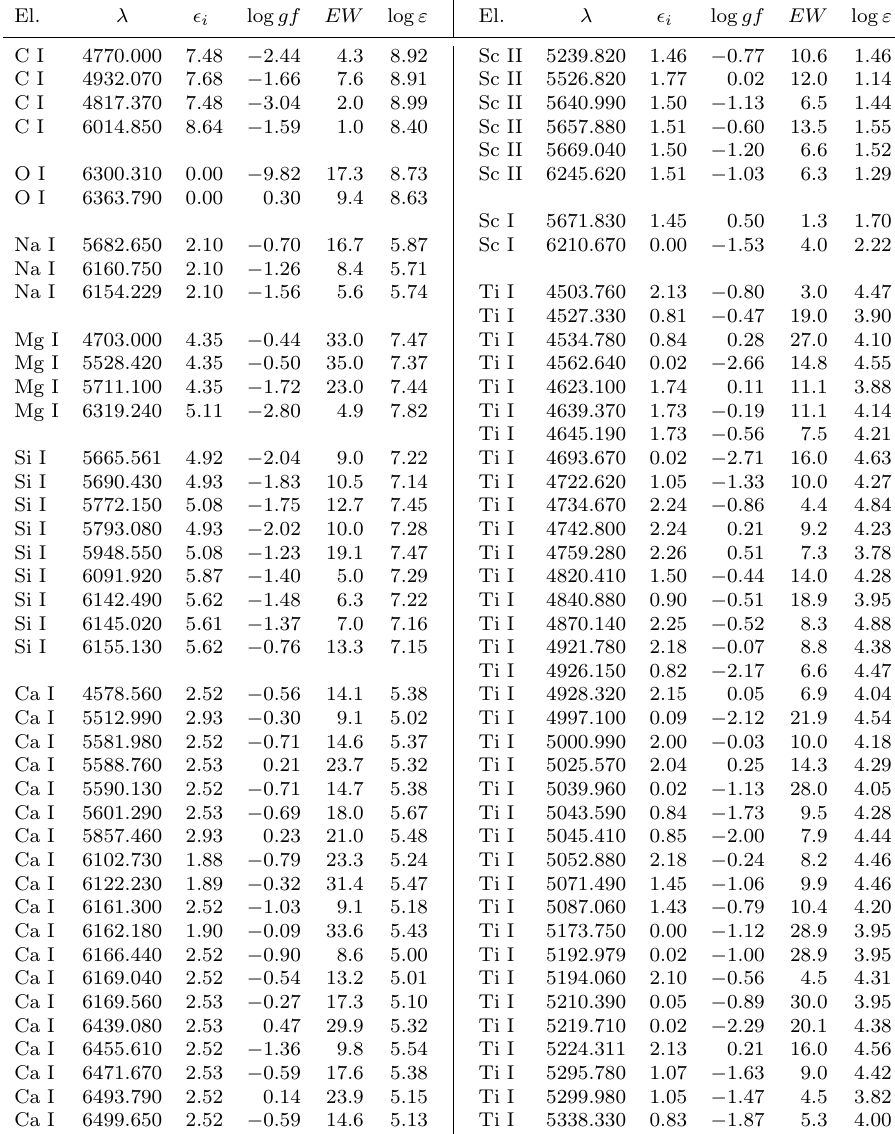
Table 4. Atomic data (wavelengths [˚A], lower level excitation potentials ϵ i [eV], oscillator strengths log gf ), equivalent widths [pm] and abundances calculated with the model parameters T eff = 4500 K, log g = 0 . 0 and ξ t = 4 . 0 km s − 1 for R Sct.